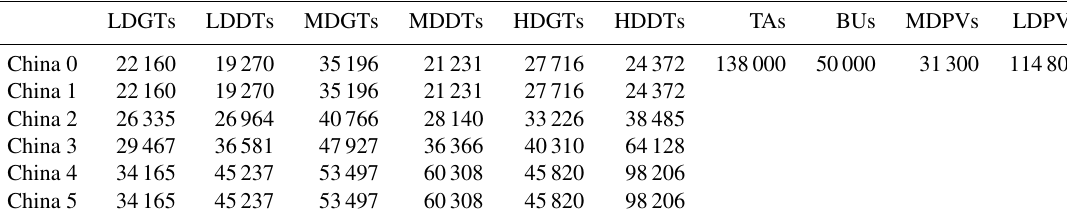
Table 3. Average annual VKT in China (kmyr − 1 ).